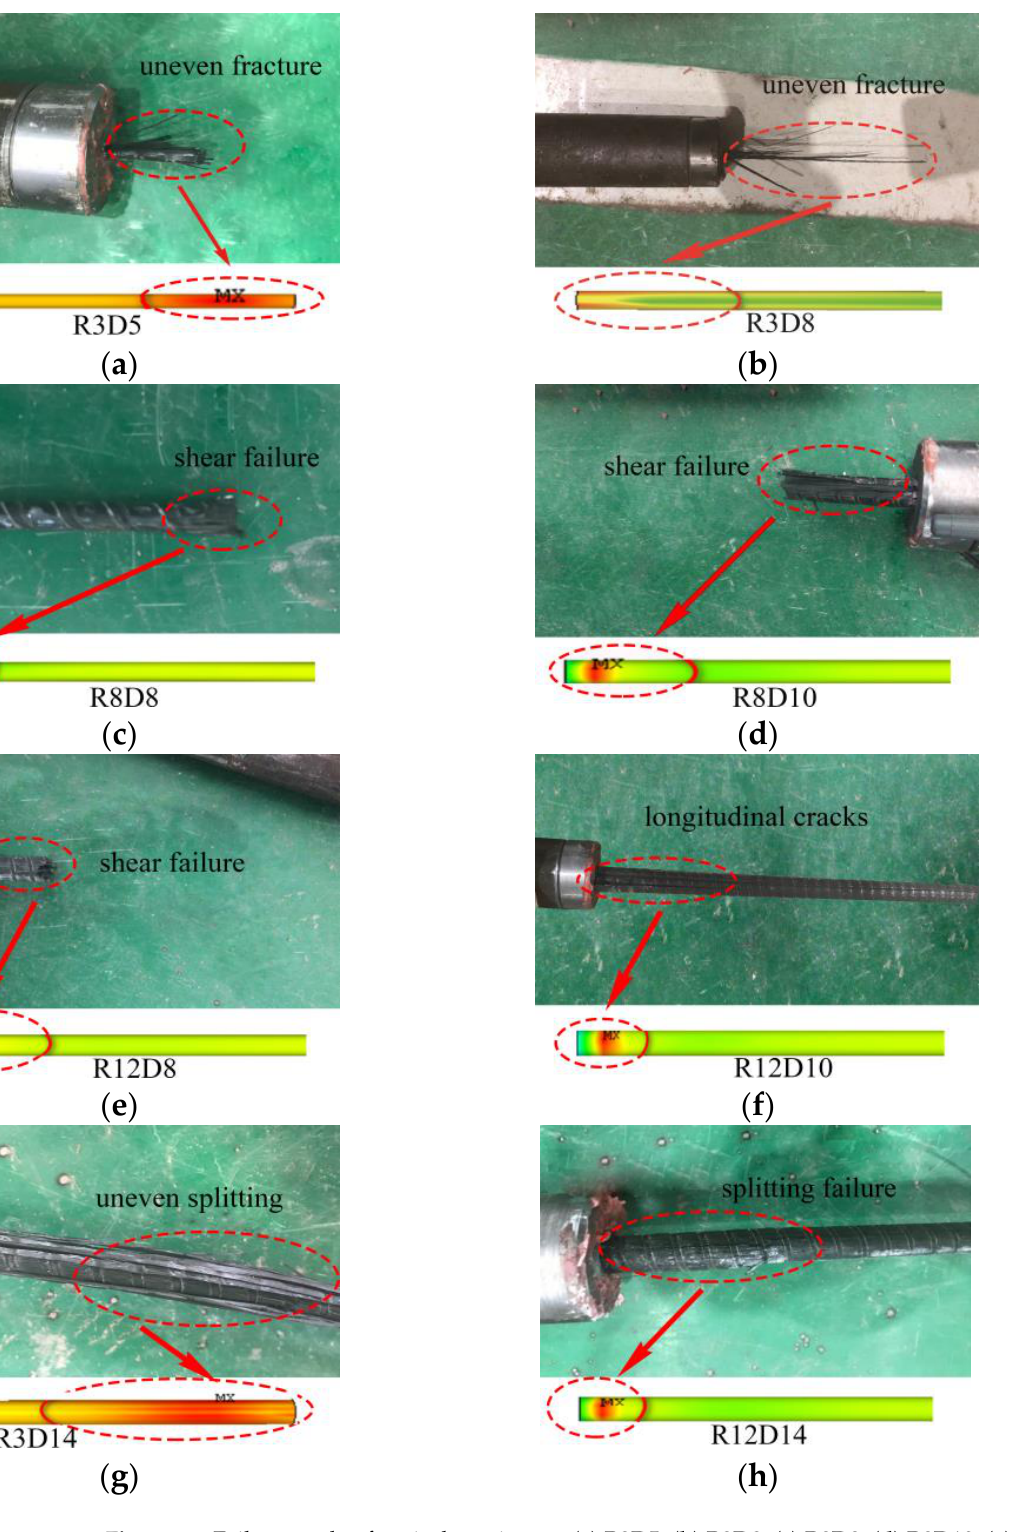
Figure 10. Failure mode of typical specimens: ( a ) R3D5; ( b ) R3D8; ( c ) R8D8; ( d ) R8D10; ( e ) R12D8; ( f ) R12D10; ( g ) R3D14; ( h ) R12D14.